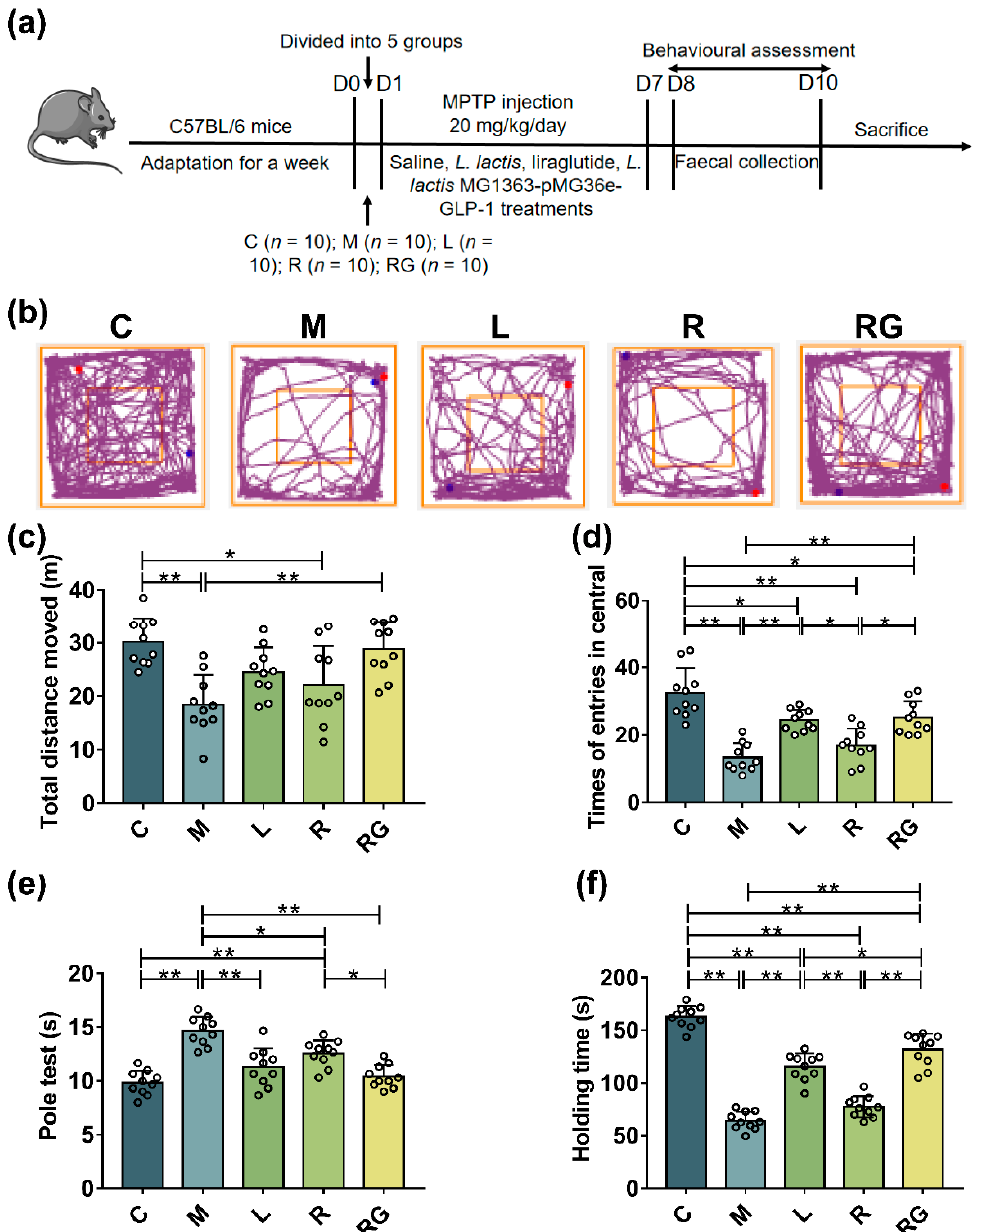
Figure 1. L. lactis MG1363-pMG36e-GLP-1 enhanced motor deficit in PD model mice. ( a ) Treatment timetable to explain experimental design of the animal experiment. ( b ) Representative traces of mice during open field test; blue point ( ● ): beginning point; red point ( ● ): end point. ( c )The overall